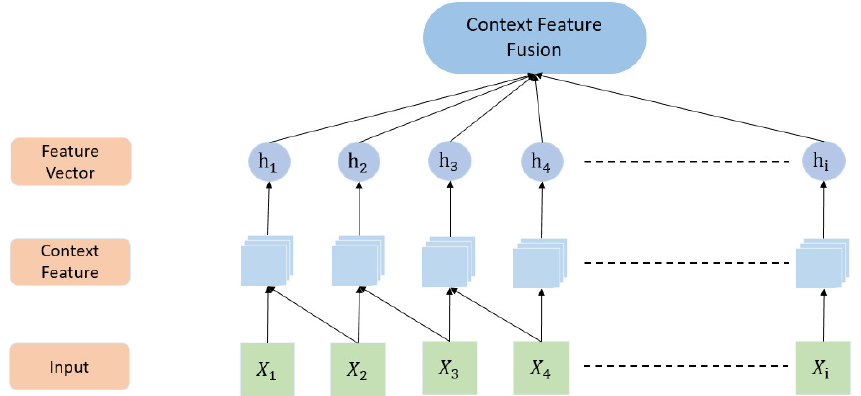
Figure 3. The context feature fusion algorithm. Through feature engineering, more context feature information is extracted. The context feature information is mapped into vectors for